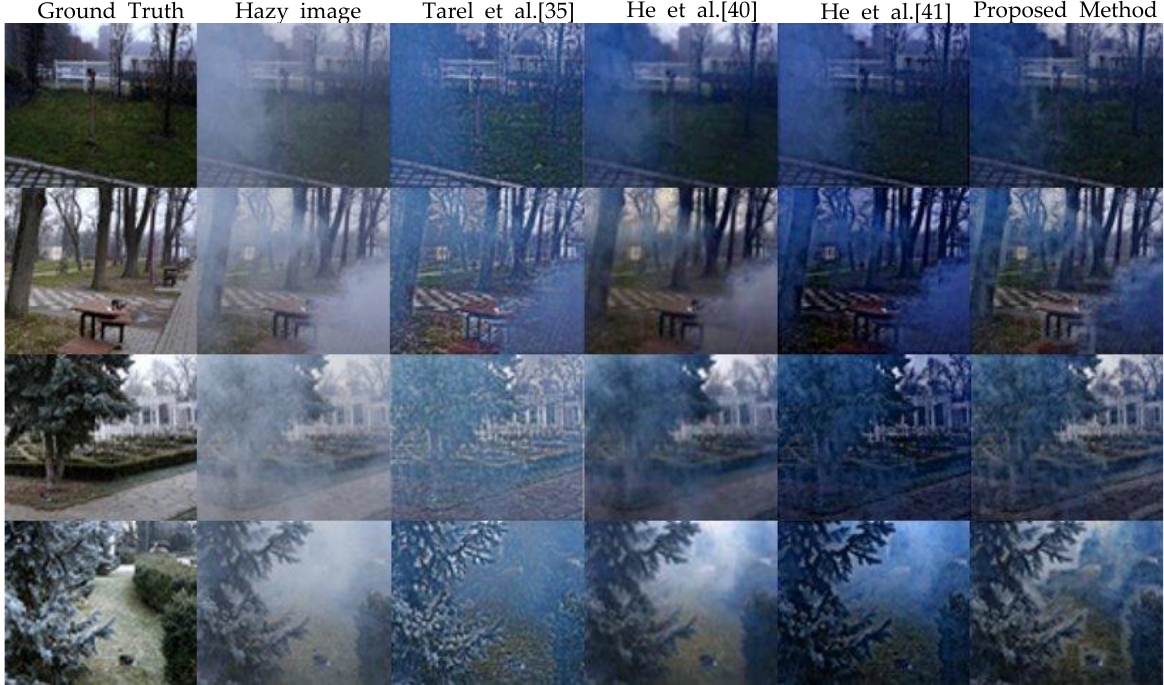
Figure 6. Transmission map of Figure 4: ( a ) DCP transmission map, ( b ) refined transmission map of the proposed method.